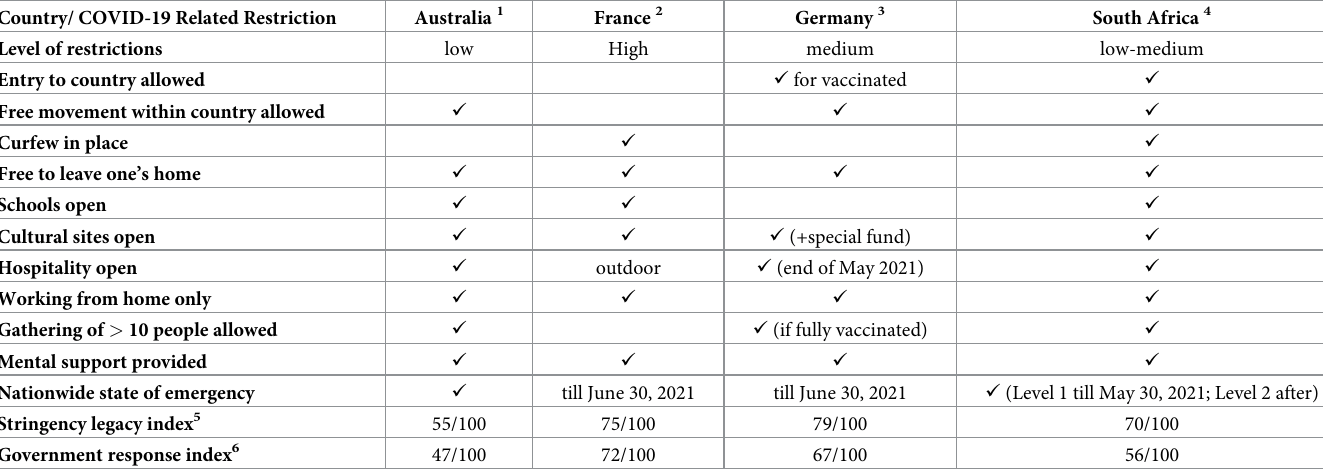
Table 4. Country-specific COVID-19 related policy measures and health restrictions during the sample